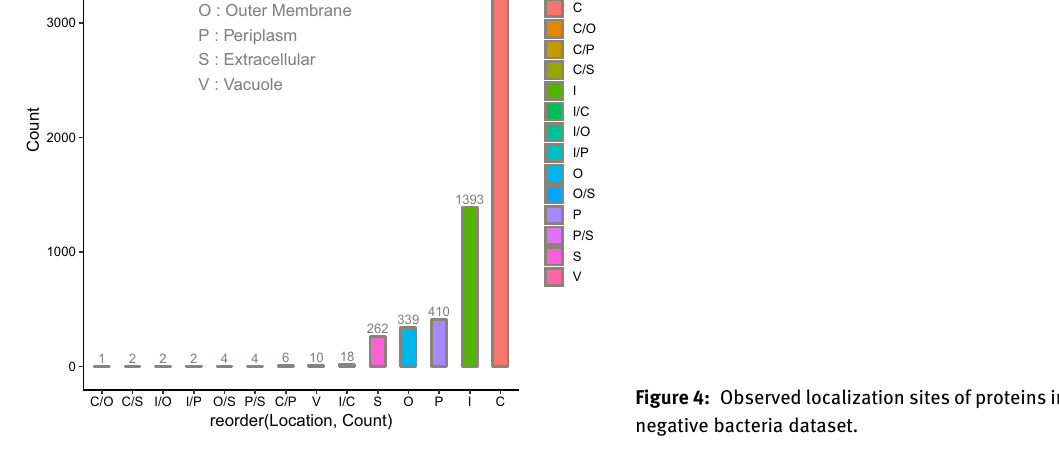
Figure 4: Observed localization sites of proteins in Gram- negative bacteria dataset.